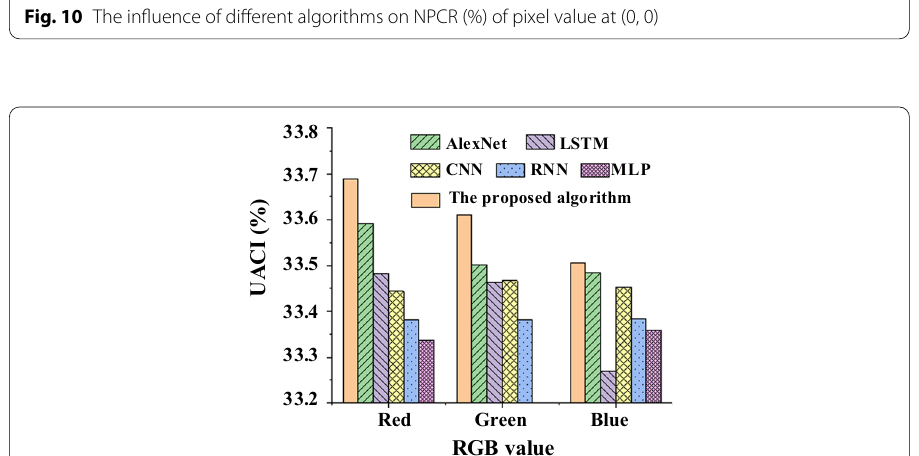
Fig. 11 The influence of different algorithms on UACI (%) of pixel value at (0,